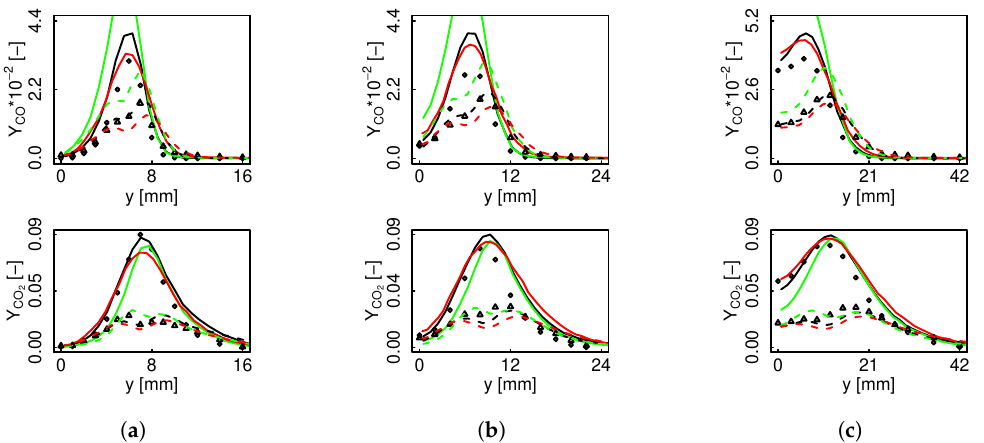
Figure 15. CO and CO 2 mean and RMS radial profiles for flame D. Black color represents non- premixed FTACLES, green color premixed FTACLES, red color FPV, solid line mean, dashed line RMS. Circles depict experimental mean, and triangles represent experimental RMS. ( a ) x / d = 7.5; ( b ) x / d = 15; ( c ) x / d =